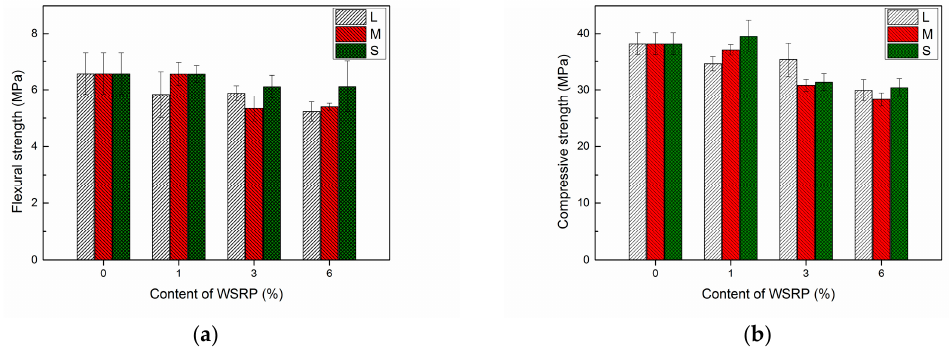
Figure 7. Influence of WSRPs incorporation on the ( a ) flexural strength and ( b ) compressive strength of specimens (with different additions of WSRPs, 0% (R), 1%, 3%, 6% of sand by volume percentage, respectively) at the age of 28 days of hydration.